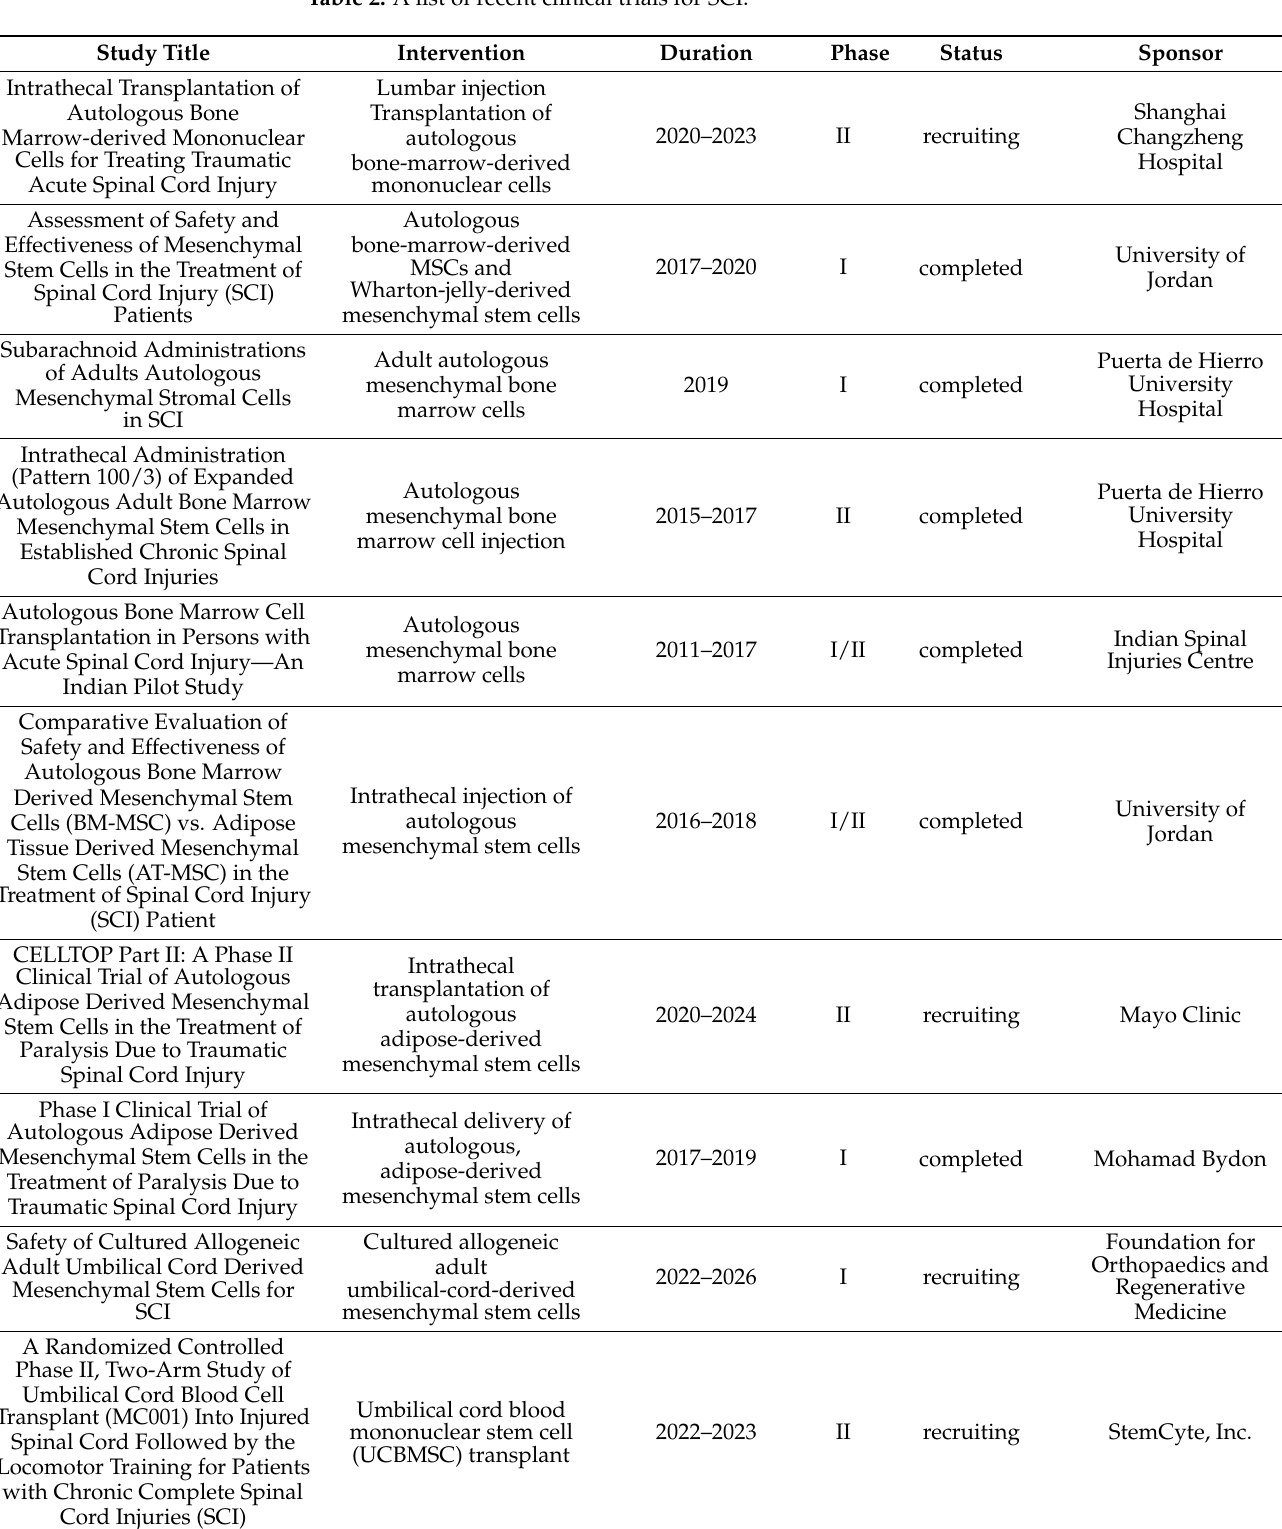
Table 2. A list of recent clinical trials for